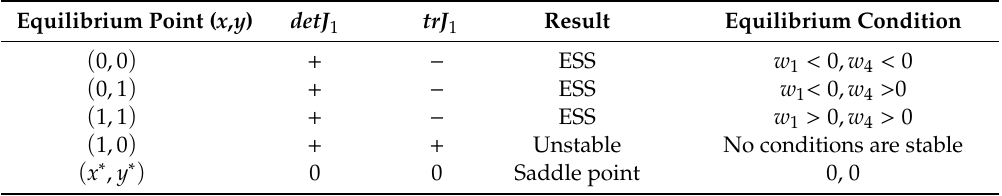
Table 3. Stability analysis between CEE and